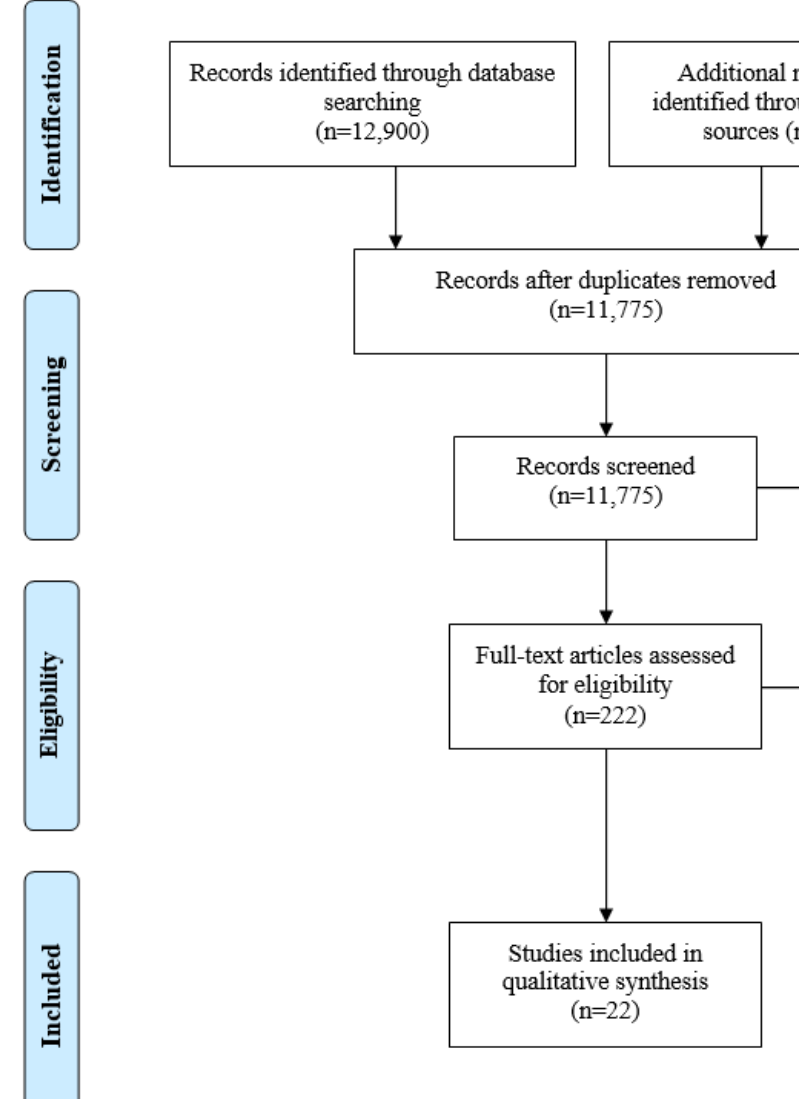
Figure 2. Preferred Reporting Items for Systematic Reviews and Meta-Analyses (PRISMA) flowchart. CE: continuing